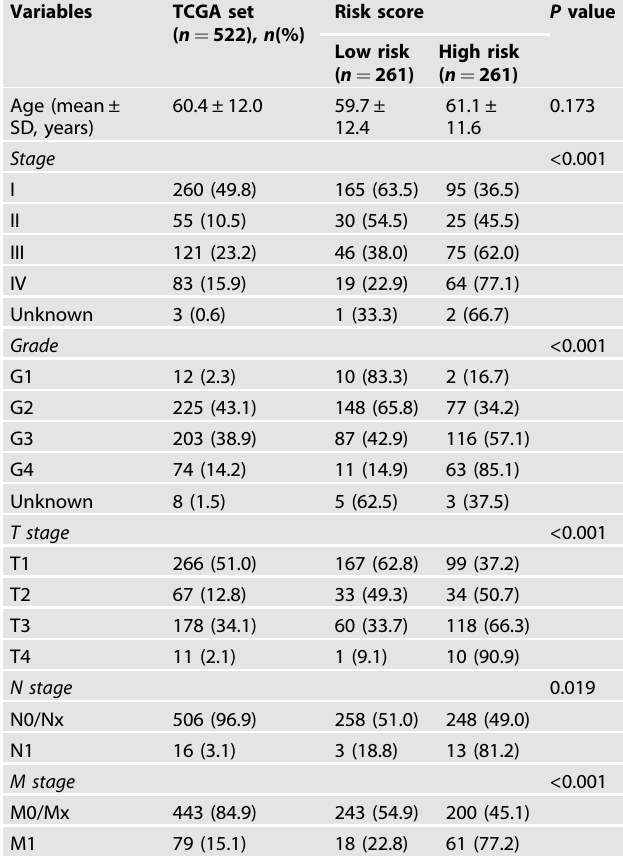
Table 1. Association between the risk score of costimulatory molecules signature and patients' clinical